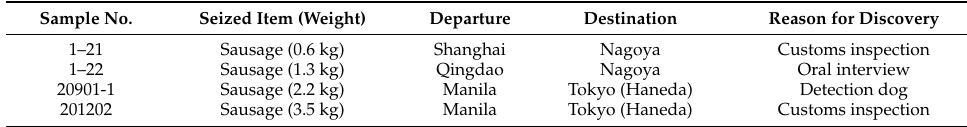
Table 1. Definition of the seized pork products used in this study. Sample